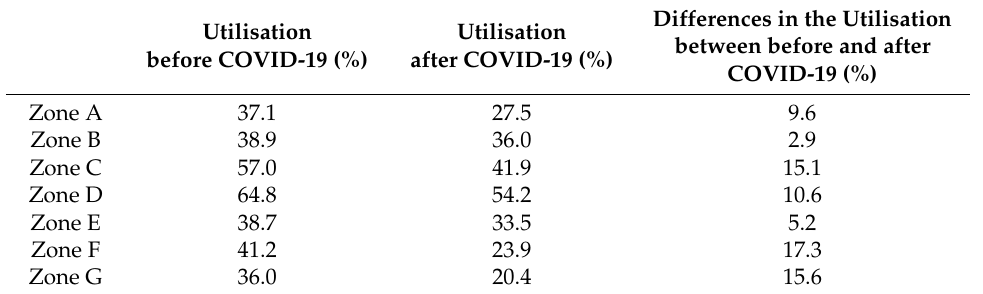
Table 3. Average utilisation of desks in the defined zones (%) before and after COVID-19.